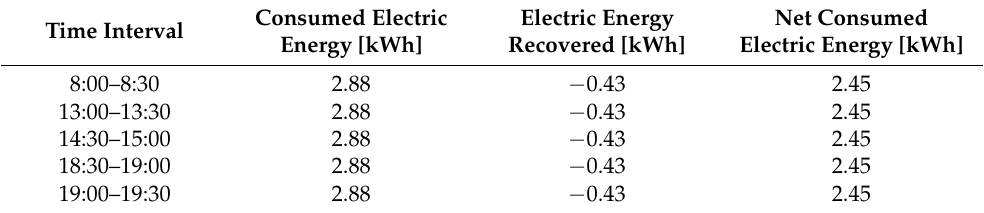
Table 9. Mobility pattern 1 energy